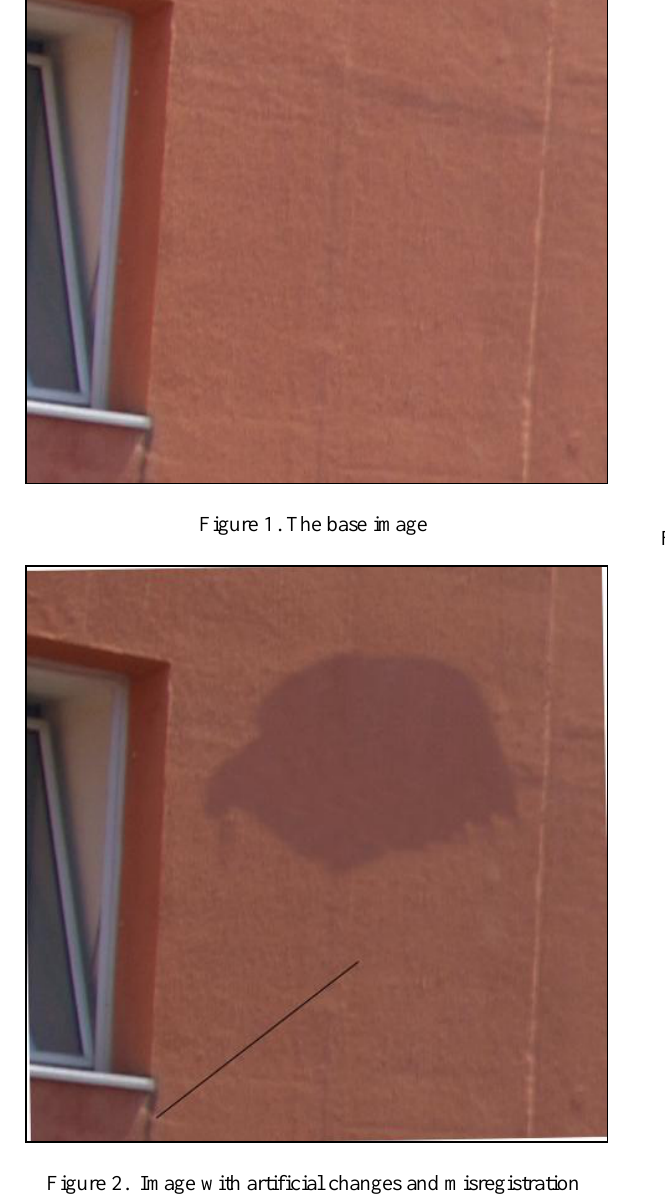
Figure 6. The base image of test